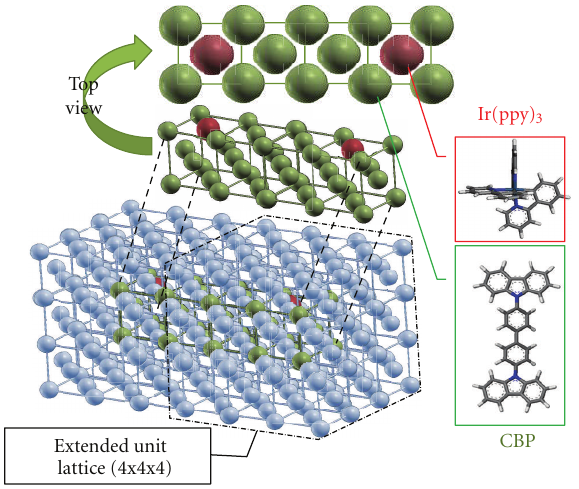
Figure 12: Imaginary molecular arrangements assuming a cubic lattice which is filled by imaginary spherical molecules as an fcc arrangement.